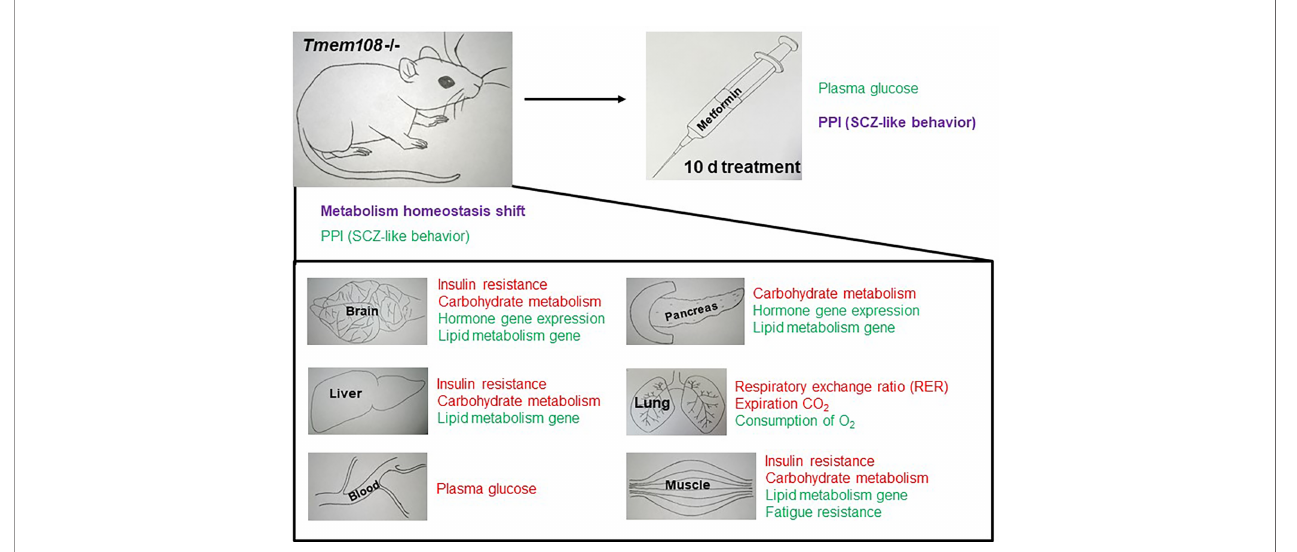
FIGURE 7 | Summary of metabolism homeostasis shift and PPI change in Tmem108 mutant mice. The phrase in red color means to increase, and the phrase in green color means decrease. Metabolism homeostasis has a complicated change, and PPI is slightly enhanced after metformin treatment for 10